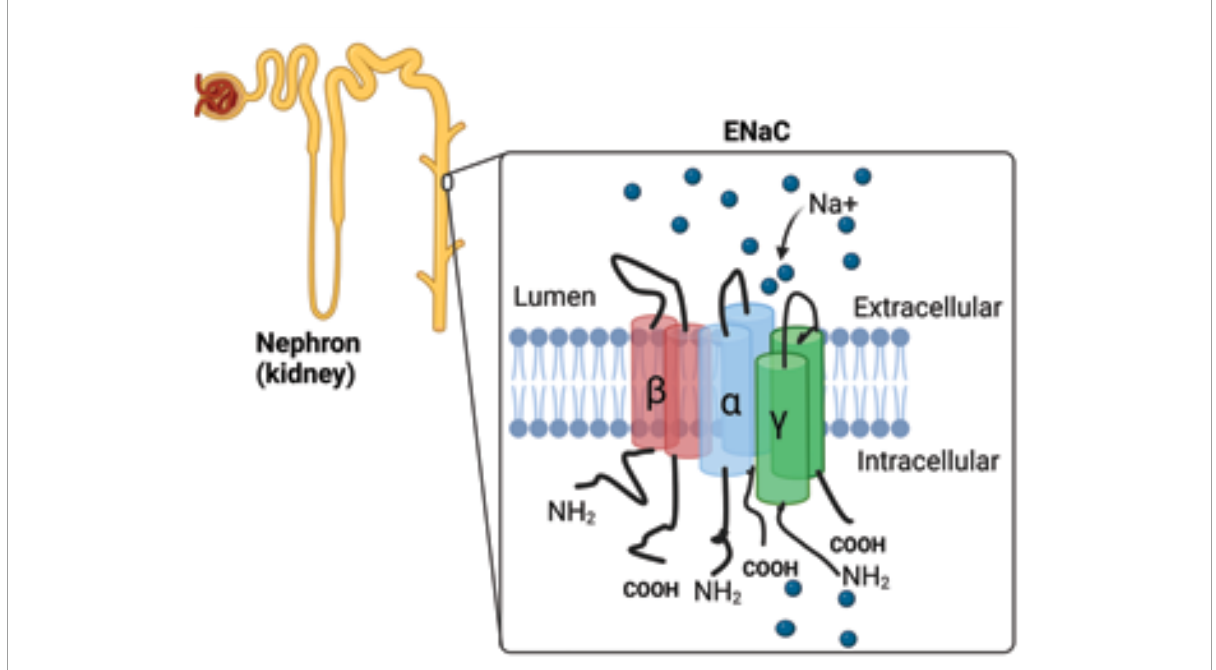
FIGURE1 Epithelial sodium channel. The epithelial Na+ channel (ENaC) is responsible for the reabsorption of sodium ions by the epithelia lining the distal part of the kidney tubule (collecting duct). The ENaC consists of three main subunits called α , β , and γ . NH 2 , amino terminal group; COOH, carboxyl group, Na+, sodium